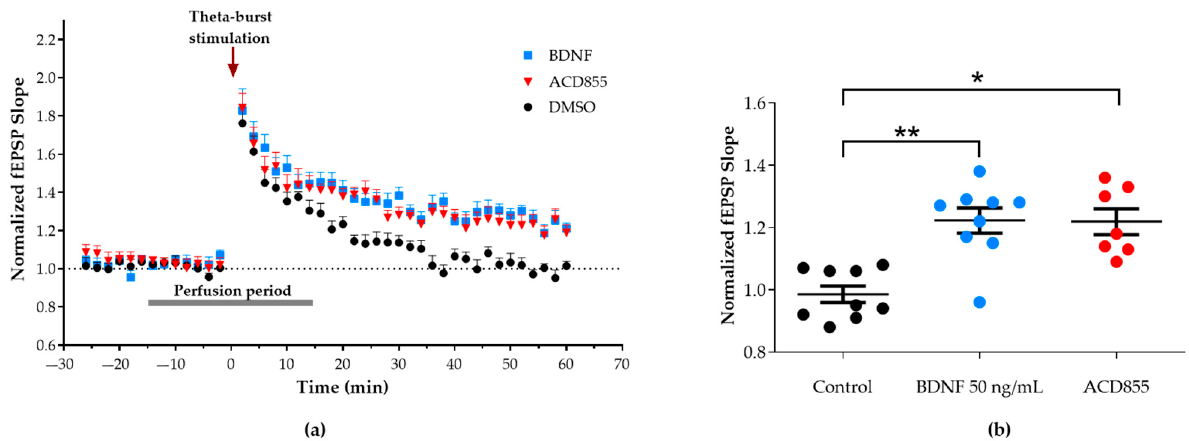
Figure 4. BDNF and ACD855 facilitates LTP induction in hippocampal rat slices. ( a ) Fifteen minutes after the addition of 50 ng/mL BDNF or 20 µ M ACD855 to the perfusion media (aCSF), a subthreshold Ø burst stimulation (arrow) was delivered to the Schaffer collaterals. BDNF and ACD855 were washed out 15 min later, and fEPSP were monitored for 60 min after the stimulation. ( b ) Evoked synaptic responses remained potentiated for 60 min after the Ø burst stimulation in slices perfused with 50 ng/mL BDNF (blue circles, n = 9 slices from 7 rats) or 20 µM ACD855 (red circles; n = 7 slices from 5 rats) when compared to control slices (black circles, n = 9 slices from 9 rats). Data are expressed as mean ± SEM. * p < 0.05 vs. control and ** p < 0.01 vs. control.